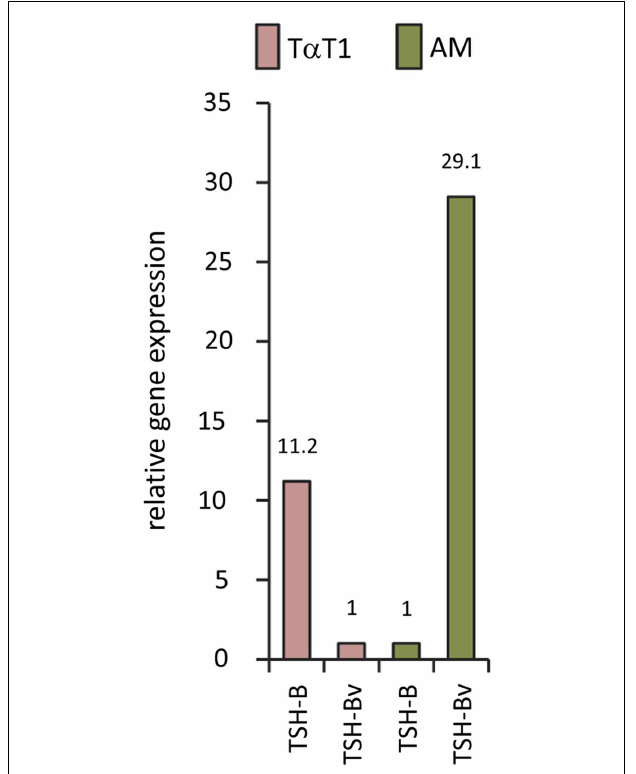
FIGURE 3 | Gene expression of nativeTSH β andTSH β v in mouseT α T1 thyrotropic cells and the mouseAM macrophage cell line, showing lowTSH β v gene expression inT α T1 cells and high expression in macrophages .